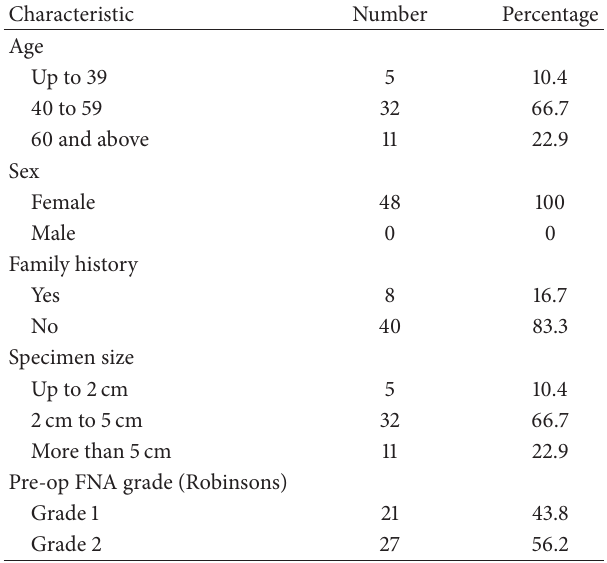
Table 3: Baseline sociodemographic